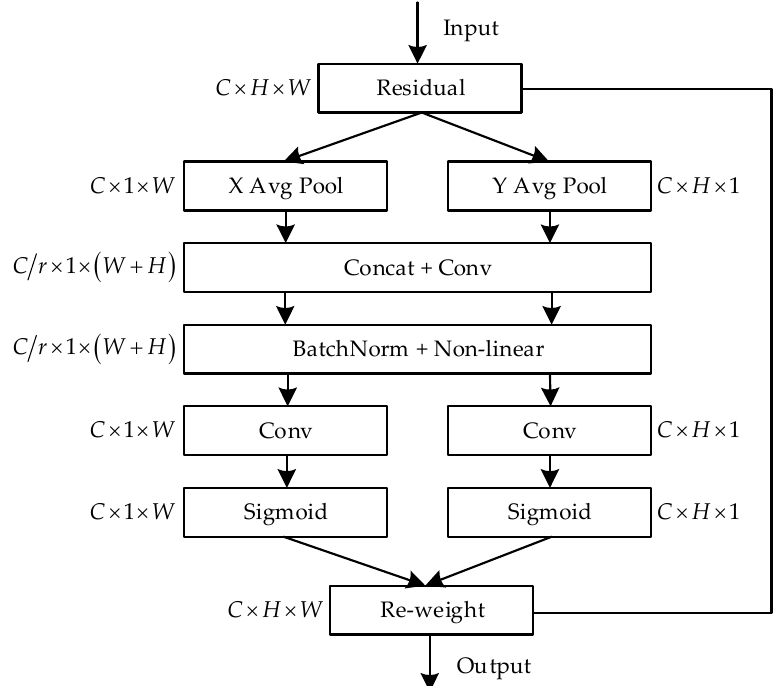
Figure 5. Coordinate Attention Block. Note: Pool stands for pooling; X/Y Avg Pool stands for average pooling in X/Y direction; FC stands for fully connected layer; Concat stands for stitching; BN stands for batch normalization; Non-linear, Sigmoid and Swish stand for nonlinear activation functions; C stands for number of channels; H stands for feature map height; W stands for feature map width; r is the channel scaling factor; each directly connected branch indicates the fusion of the input feature map with the feature map obtained through convolution and other operations.